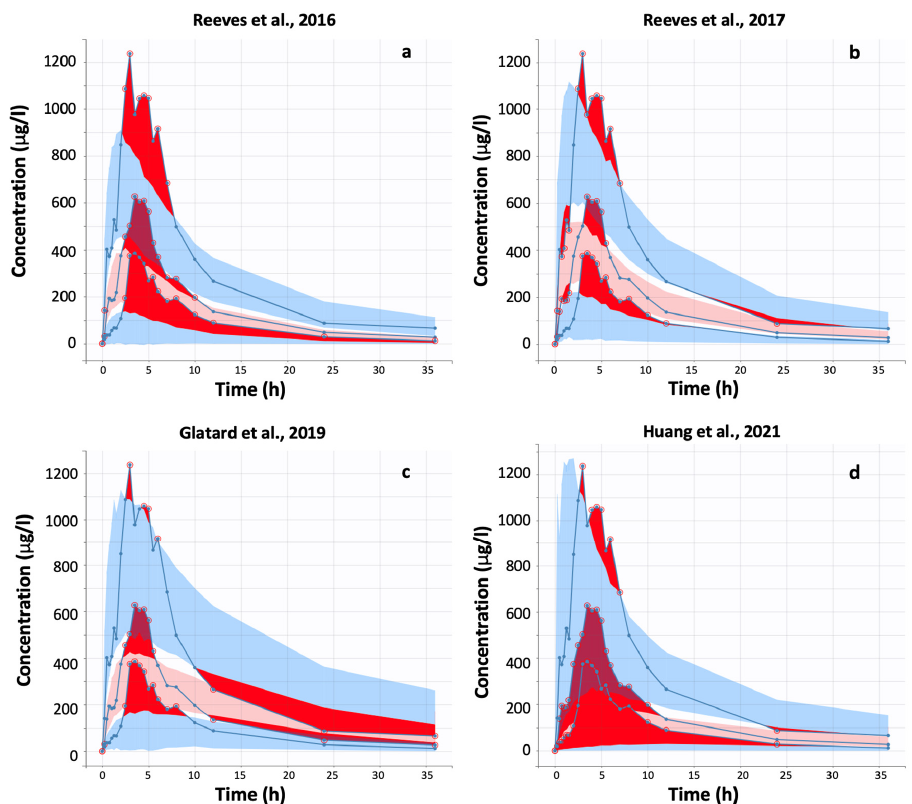
Figure A1. Visual predictive check plots for the literature models (Reeves et al., 2016 [23], Reeves et al., 2017 [24], Glatard et al., 2019 [25], Huang et al., 2021 [26]). All covariates were patient-specific whereas the model estimates (structural model, mean model parameter, between-subject variabilities, error model) were taken from the published literature (summarized in Table 3). The 90% confidence intervals are shown in blue, and the 10th, 50th, and 90th percentiles of the actual data are shown in blue as well (10th, 50th, and 90th percentiles). Data points represent individual observations. Red areas and points indicate outliers. One thousand Monte Carlo simulations were run.